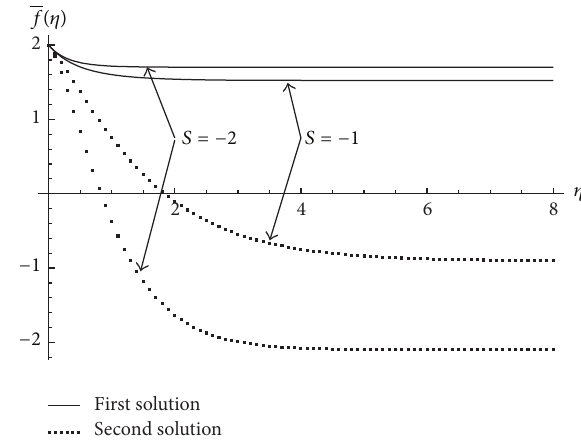
Table 12: Comparison between the first expression of the first-order approximate solutions 𝑓(𝜂) given by (55) obtained by OHAM and numerical results for 𝛾 = 2 and 𝑆 = −2 (error = |𝑓 (𝜂)| ). 𝑓 numerical